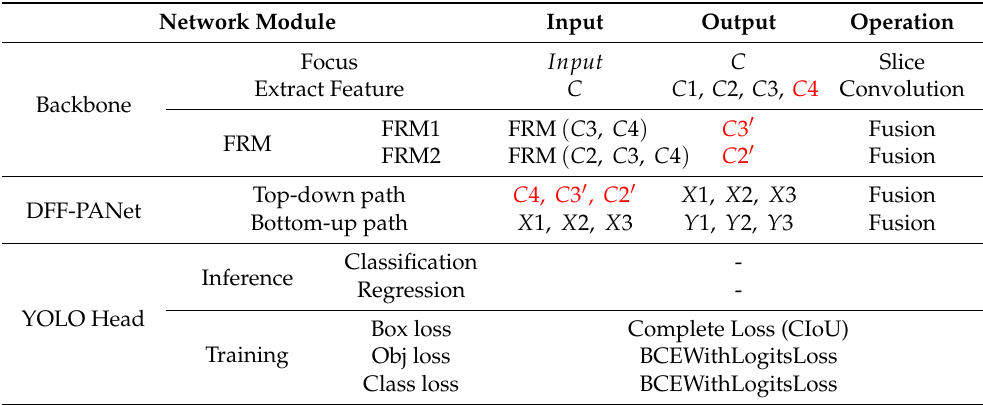
Table 2. The network structure setting. The red part represents the feature maps to be sent into DFF-PANet for feature fusion. Network Module Input Output Operation Focus Input C Slice Backbone